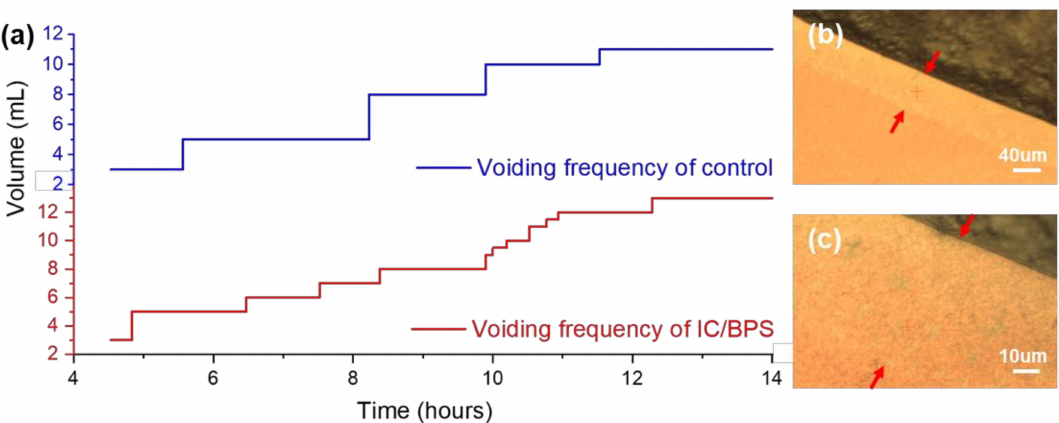
Figure 2. ( a ) Measurement of voiding function in the control group and the IC/BPS animal group at 7 days after HCl treatment. Optical microscope images of a Raman measurement region diffused from a sample droplet into a nanoporous area, indicated by red arrows: ( b ) 10 × and (c) 40 ×